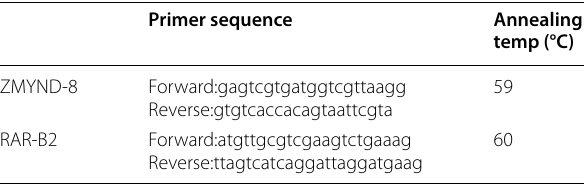
Table 2 Primer sequencing for the Quantitative